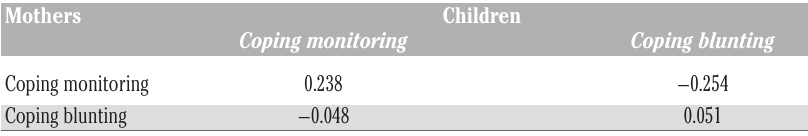
Table 5. Experimental group: correlations between children’s coping strategies and their mother’s coping strategies (Pearson correlation